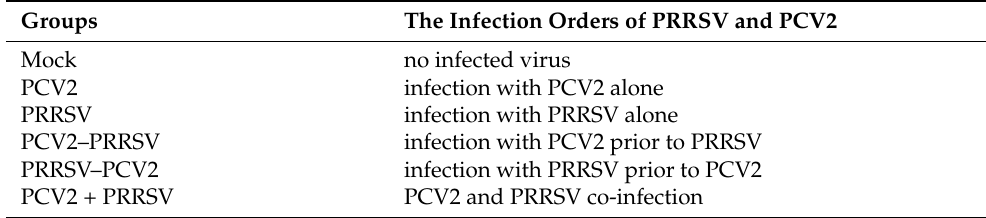
Table 1. Trial design (groups and infection orders of PRRSV and PCV2). Groups The Infection Orders of PRRSV and PCV2 no infected